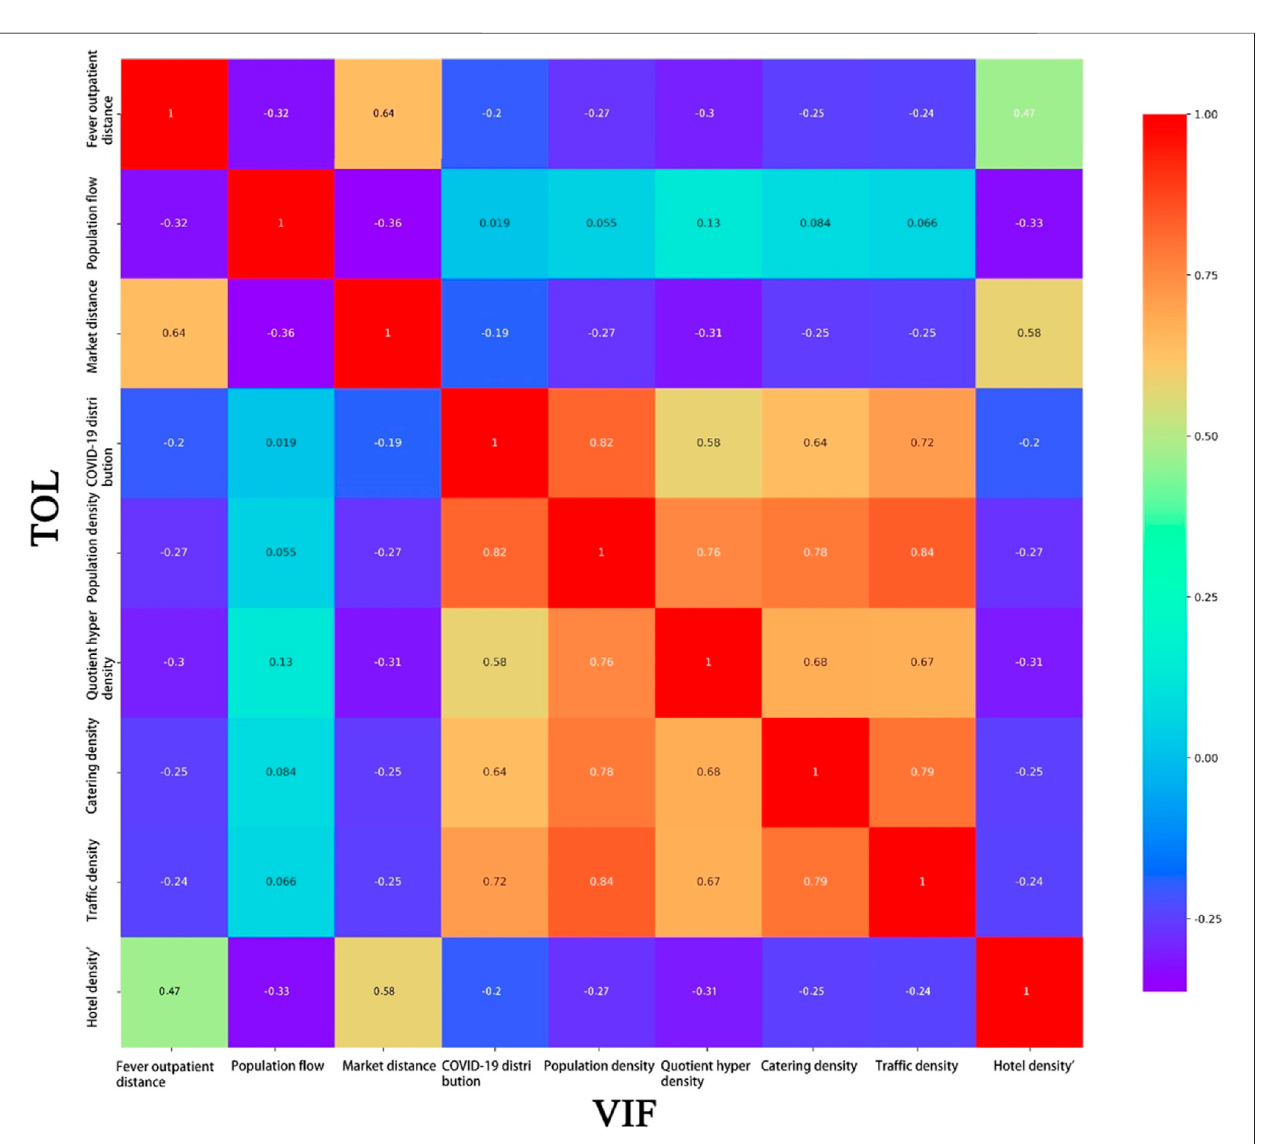
Frontiers in Environmental Science |